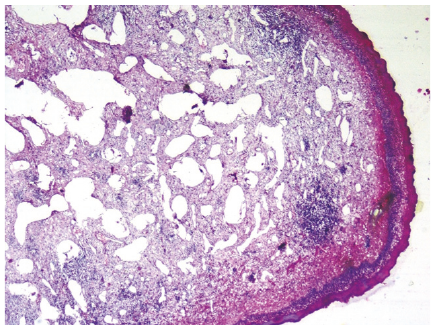
Figure 2: Histopathological examination showing tissue lined by stratified squamous epithelium lining with numerous dilated lym- phatic channels present in underlying parenchyma (hematoxylin and eosin, 4x total magnification).